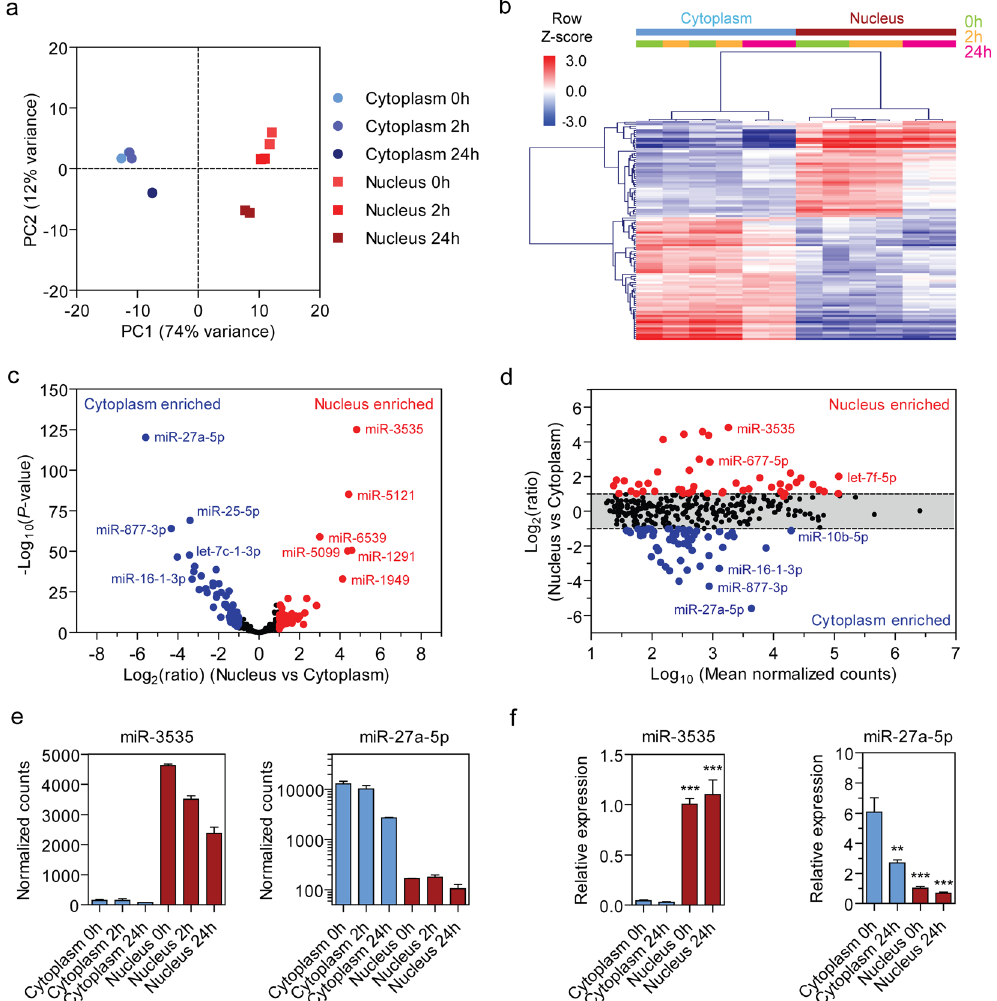
Figure 2. Nuclear and cytoplasmic small RNAs. ( a ) Principal component analysis (PCA) shows tight clustering of biological replicates. Principal component one (PC1) shows the separation between nuclear and cytoplasmic samples (74% of variation), whereas PC2 depicts the response to hypoxic stress (12% of variation). ( b ) Hierarchical clustering of differential expression between nuclear and cytoplasmic samples (adjusted P < 0.01, fold change ≥ |2|). Scale bars show mean-centered log 2 normalized counts (row Z-score) where red and blue indicate higher and lower than mean abundance respectively. ( c ) Volcano plot depicting nuclear and cytoplasmic miRNA enrichment. ( d ) MA plot analysis of location-enriched miRNAs showing that differentially nuclear/cytoplasm-enriched miRNAs were observed over a broad range of absolute expression values. ( e ) The two most location-enriched miRNAs across the dataset were miR-3535 (in the nucleus) and miR-27a-5p (in the cytoplasm). ( f ) miRNA-expression levels of nuclear (miR-3535) and cytoplasmic (miR-27a-5p) miRNAs identified by miRNA-seq were validated by RT-qPCR. miRNA levels were normalized to miR-186–5p and the mean value of the Nucleus 0 h group scaled to a value of one. Values are mean ± SEM, n = 2 (sRNA-seq), n = 3 (RT-qPCR), * P < 0.05, ** P < 0.01, *** P < 0.001 (one-way ANOVA with Bonferroni post hoc test, comparisons are to the Cytoplasm 0 h